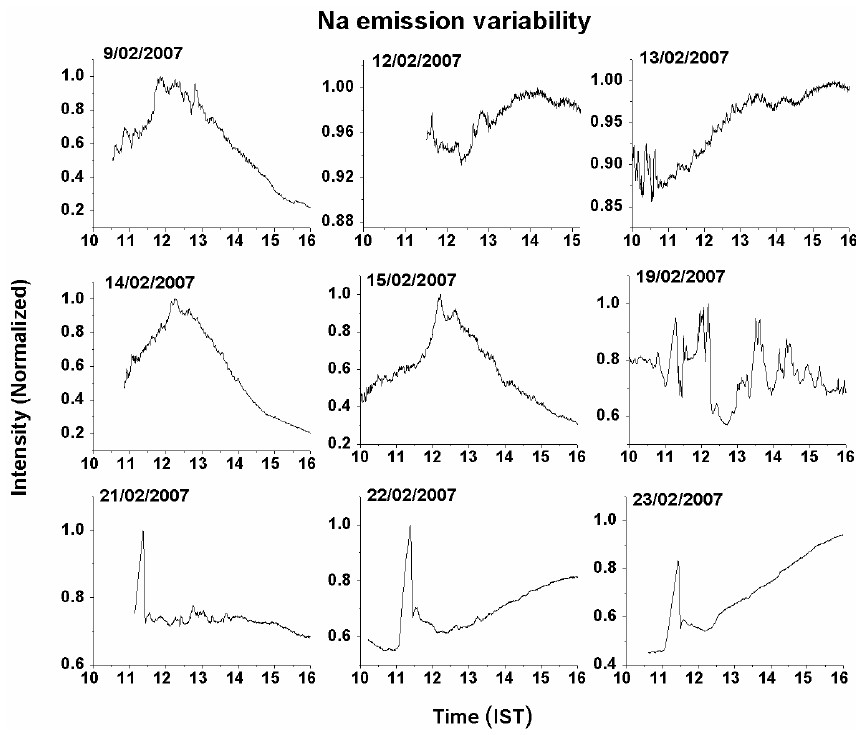
Fig. 4. Temporal variations in the observed Na emission intensities on the 9 days during February 2007.